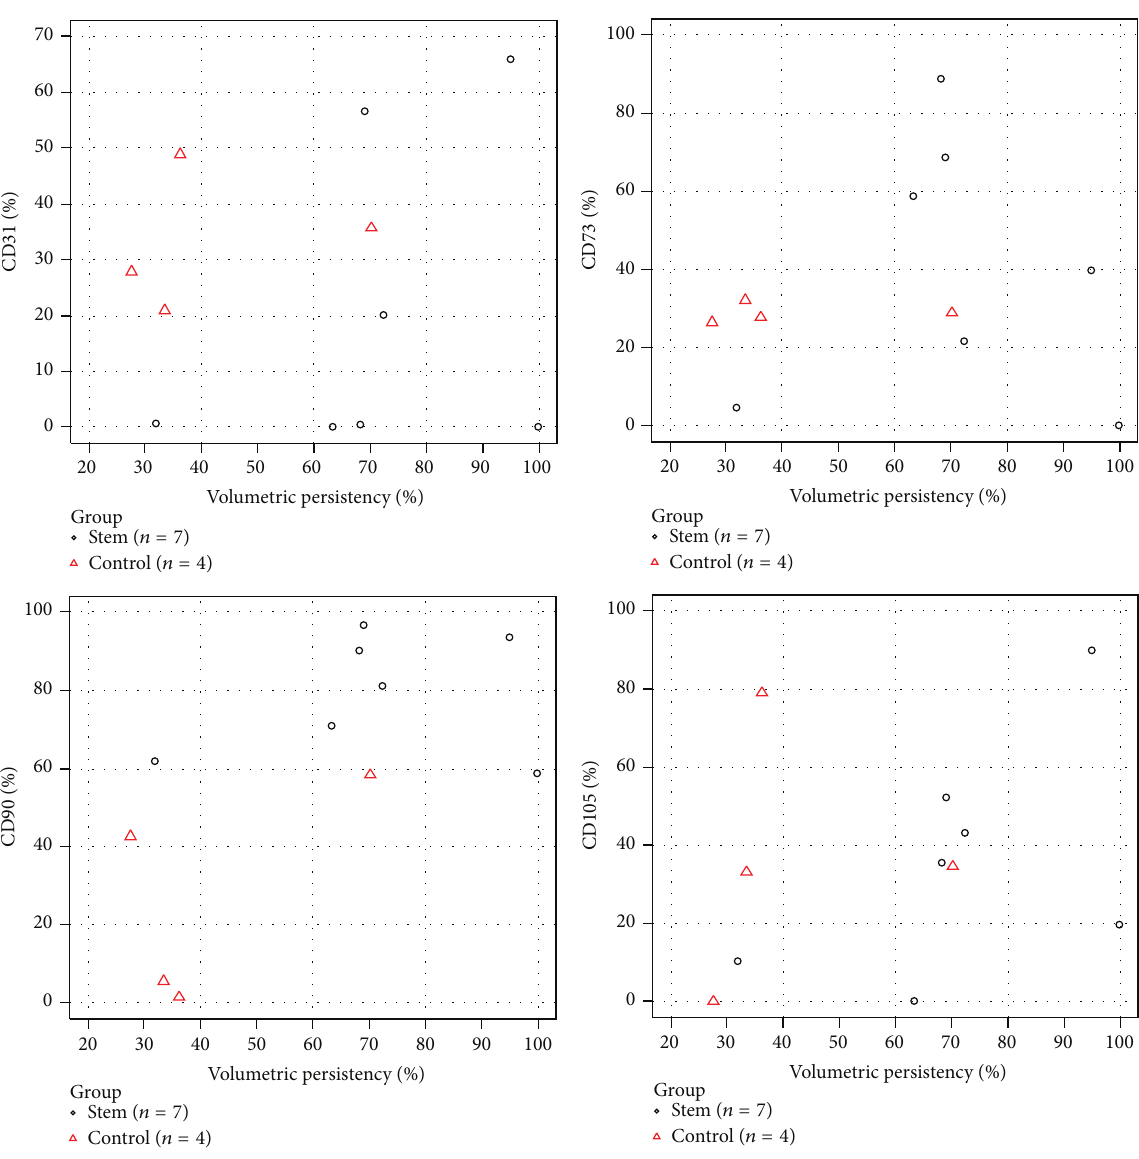
Figure 2: Charts show a positive correlation between surface markers expression and volumetric persistence for CD31, CD73, CD90, and